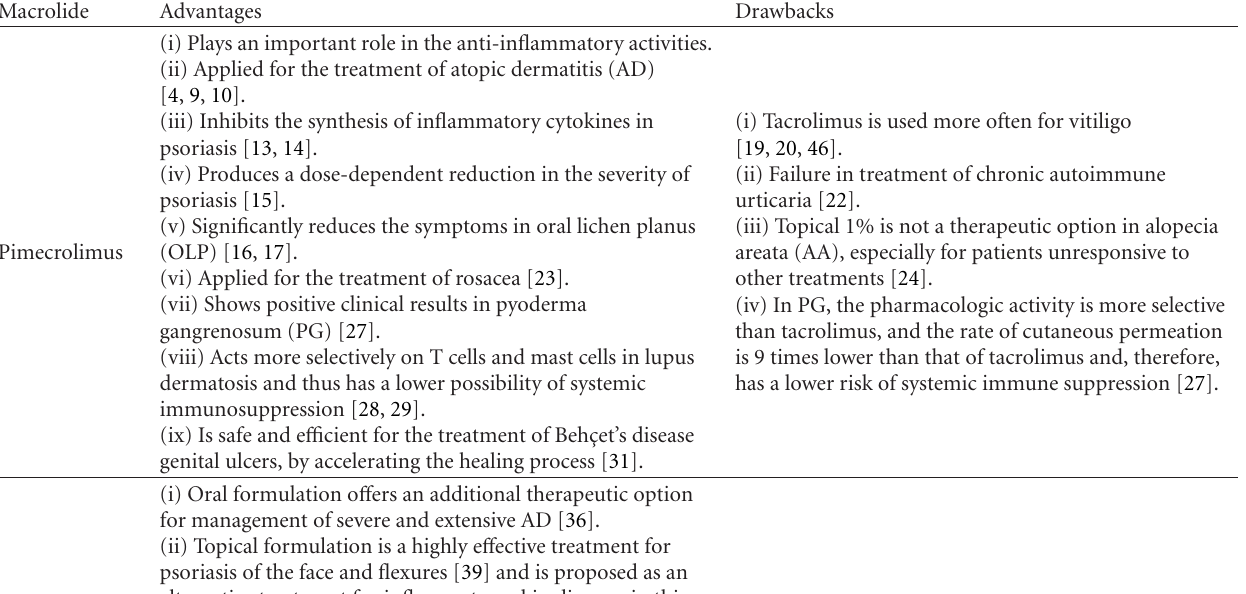
Table 1: Main advantages and drawbacks of di ff erent nonantibiotic macrolides in skin